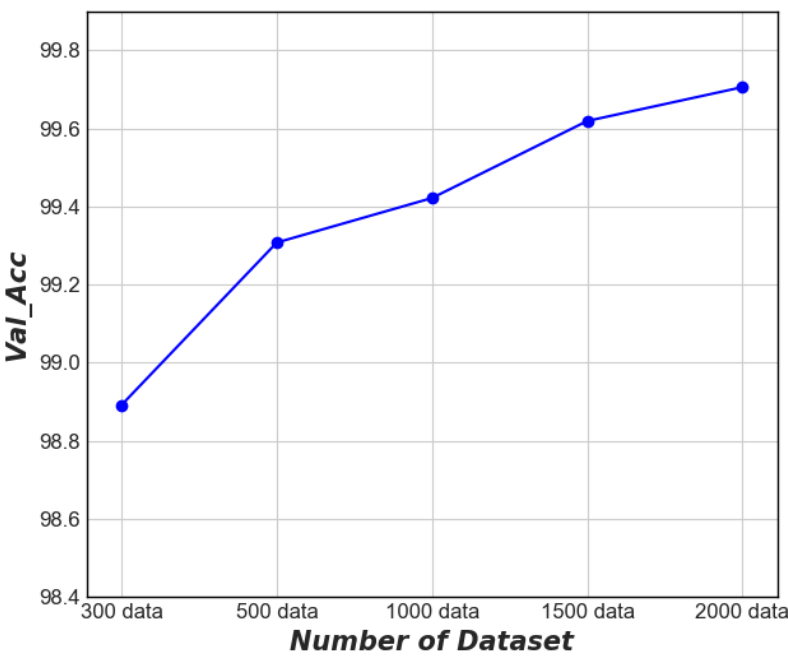
Figure 13. Accuracy of the outlet heat prediction on validation dataset.